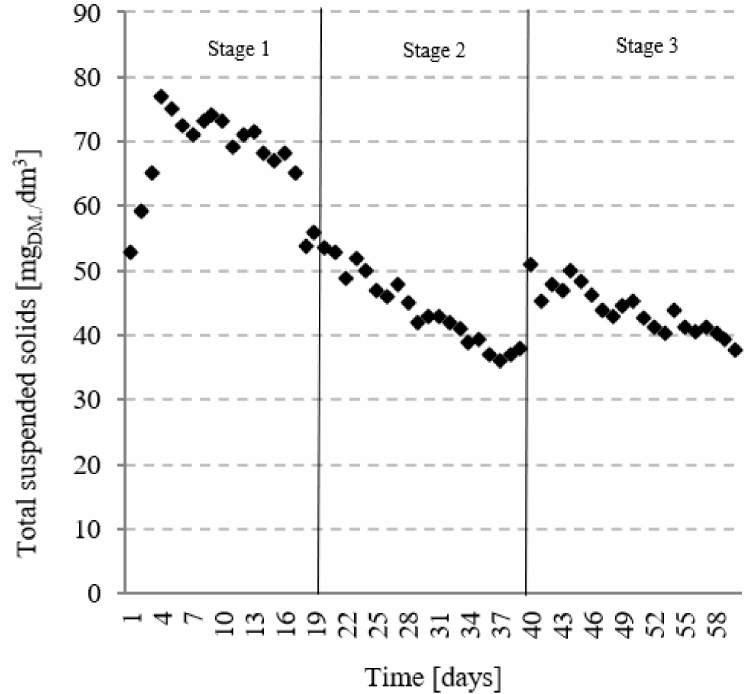
Figure 7. Changes in the total suspended solids concentration in the treated e ffl uent.